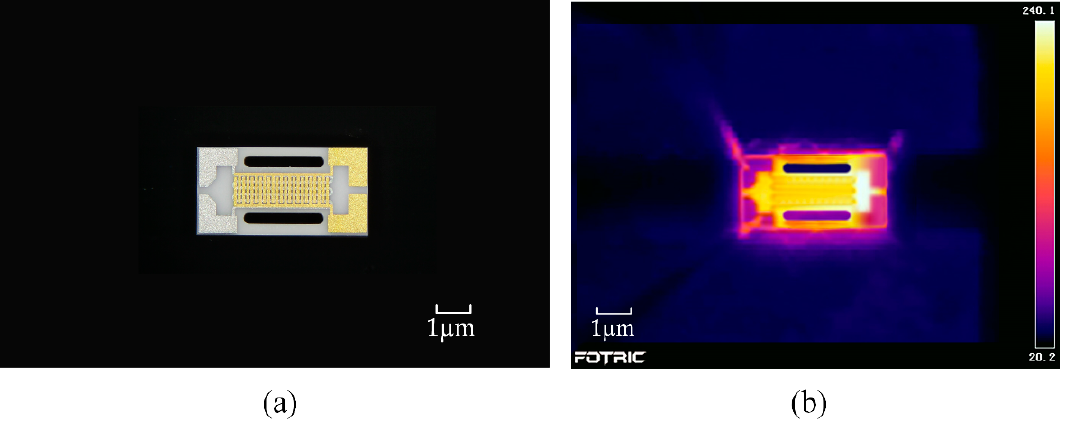
Figure 10. ( a ) Physical view of the completed preparation, ( b ) thermal image of the micro-hotplate, and. Using a programmable power supply (E36312A, Keysight Technologies, Santa Rosa, CA, USA) with 0.5 V steps, heat generation was performed at different voltages